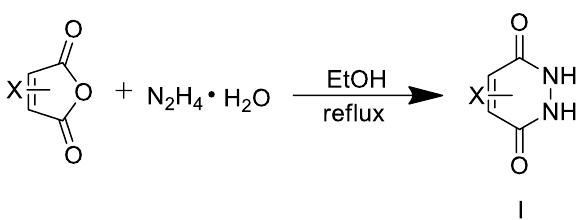
Figure 4. Synthesis of six-membered ring isomers.